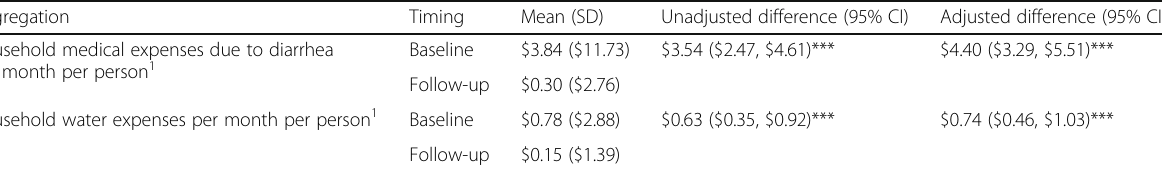
Table 5 Economic impact (FJ$) of diarrhea by age group at baseline and follow-up